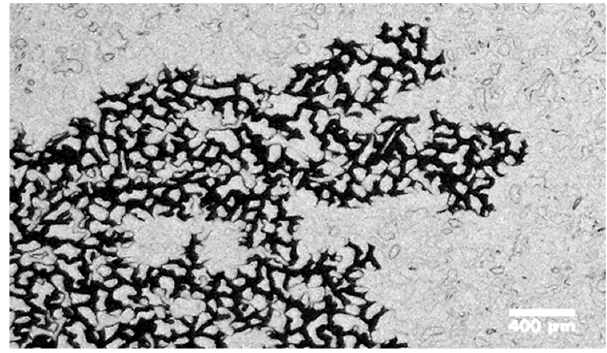
Figure 8. An image of wetting fluids (black) displacing nonwetting fluids (white) in the microfluidic device.